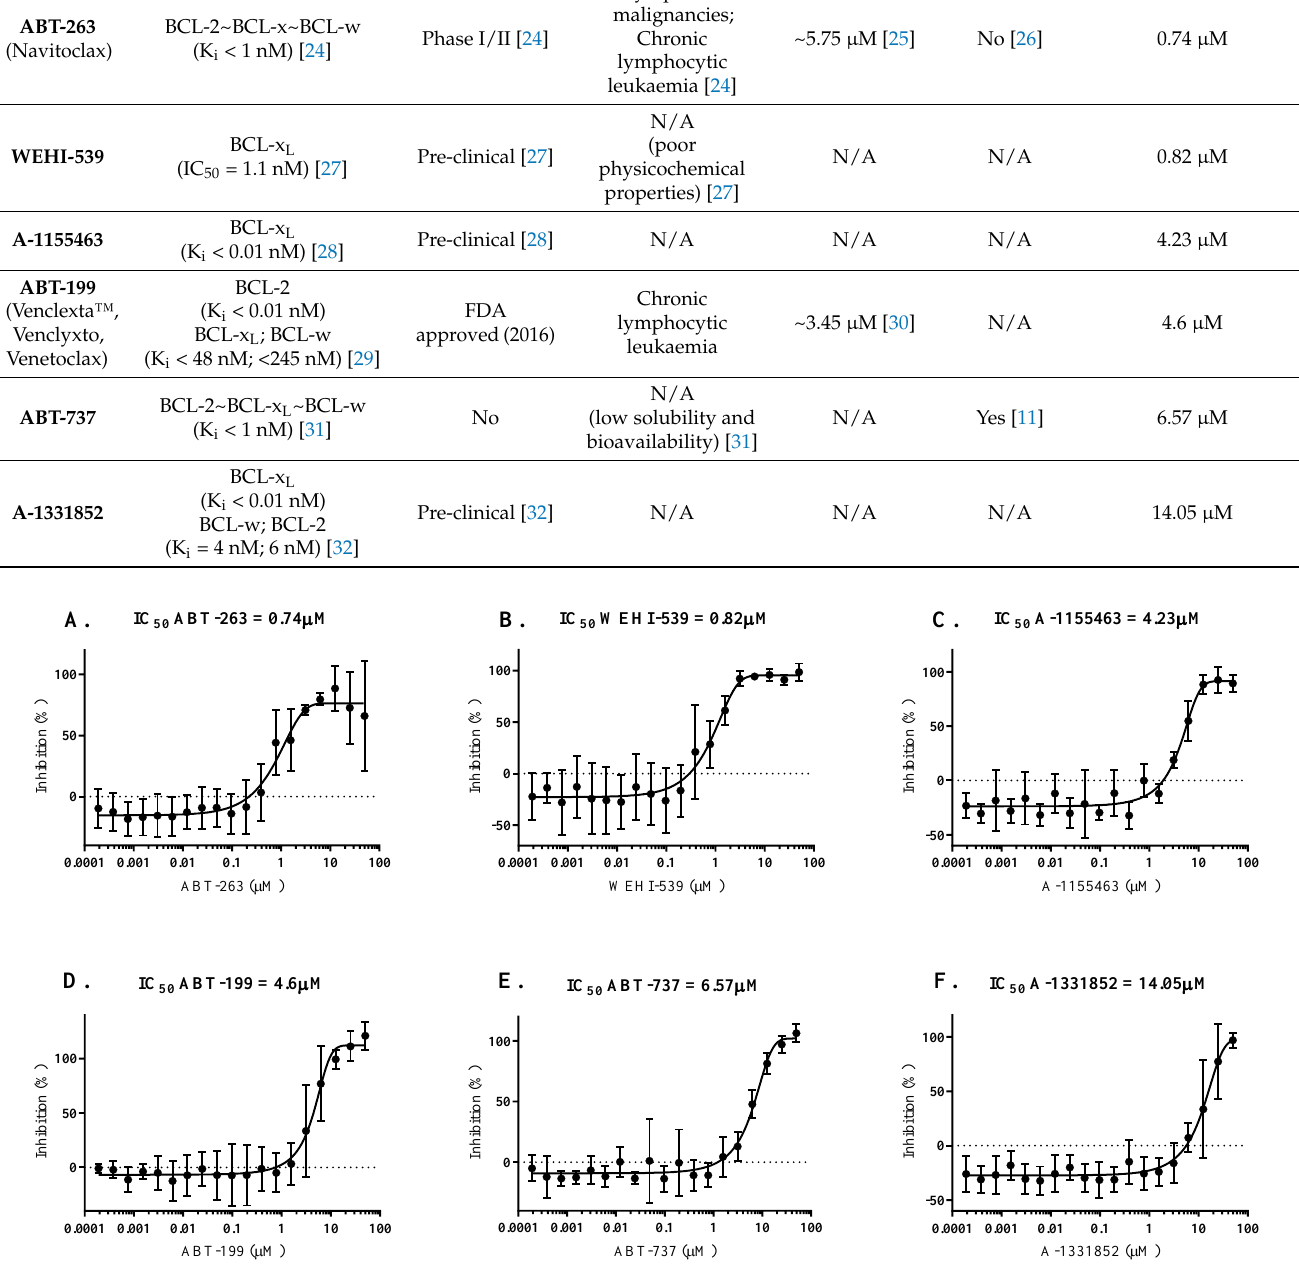
Figure 1. Impact of BCL-x L inhibitors on P. falciparum growth in vitro . ( A ) ABT-263. ( B ) WEHI-539. ( C ) A-1155463. ( D ) ABT-199. ( E ) ABT-737. ( F ) A-1331852. Growth assays of six BCL-x L inhibitors were conducted over 72 h on an asynchronous parasite culture, and the IC 50 was calculated based on three independent biological replicates ( n = 3, mean +/ − SD).